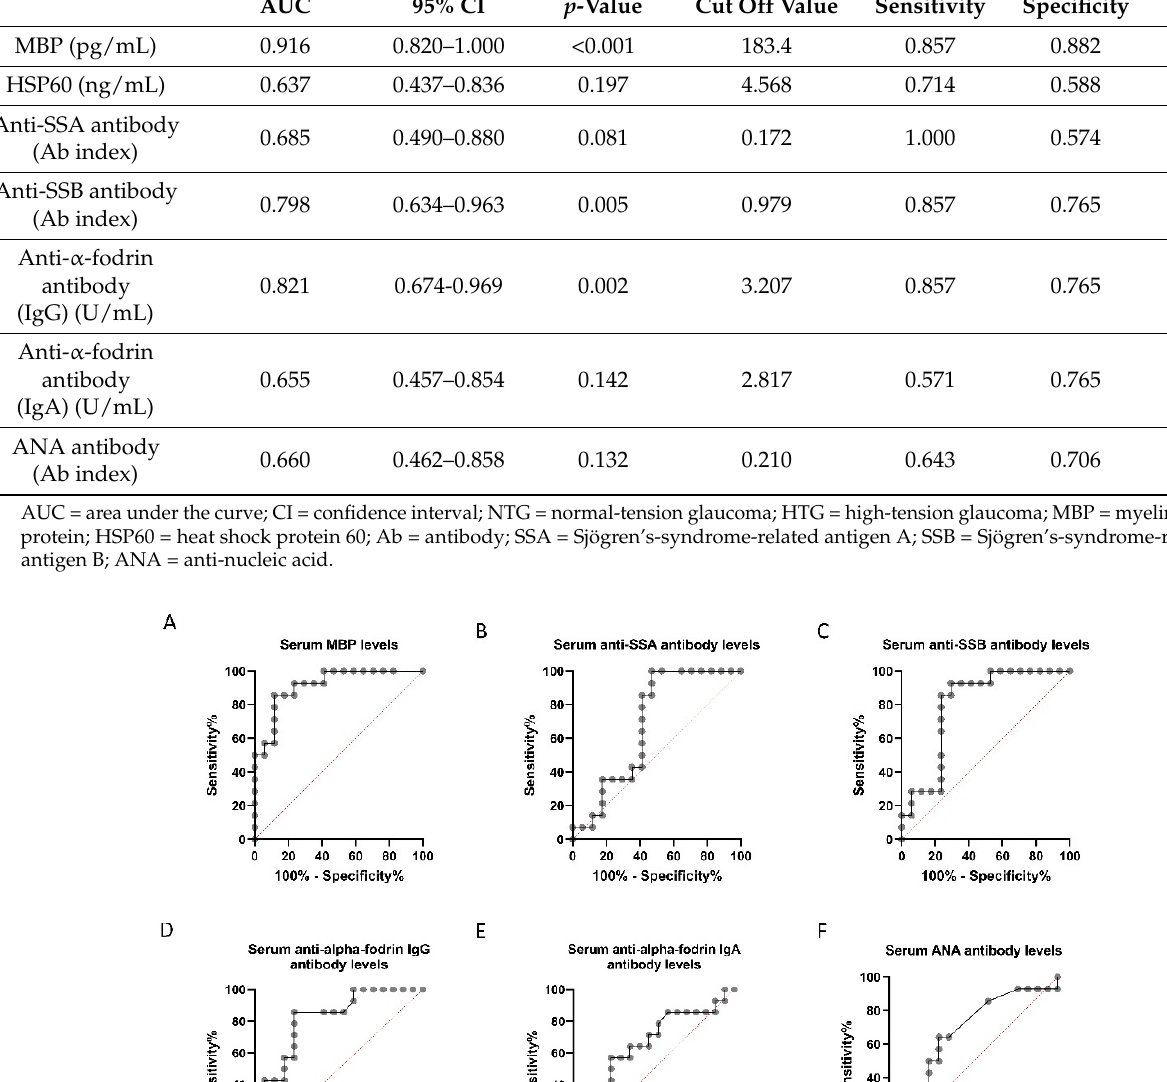
Table 5. Receiver operating characteristics curve analysis for discrimination between control and NTG.